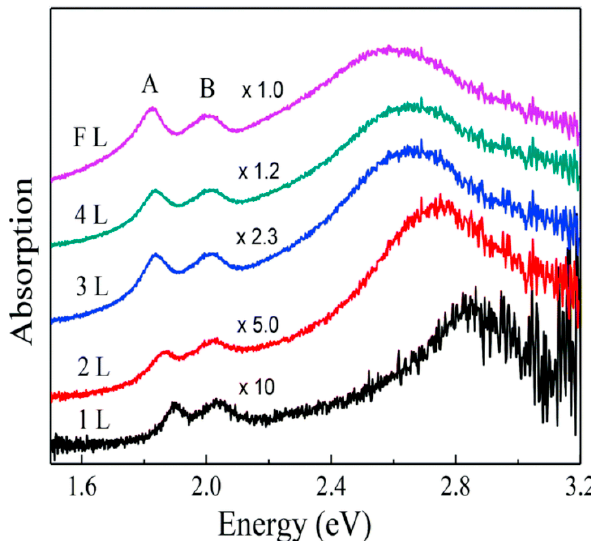
Figure 3. Absorption spectrum of MoS 2 varying the number of layers from 1 layer (1L) to few layers (FL), where A and B represent the excitonic peaks of MoS 2 . Reprinted with permission from ref. [20]. 2014, Creative Commons Attribution 3.0 Unported Licence.